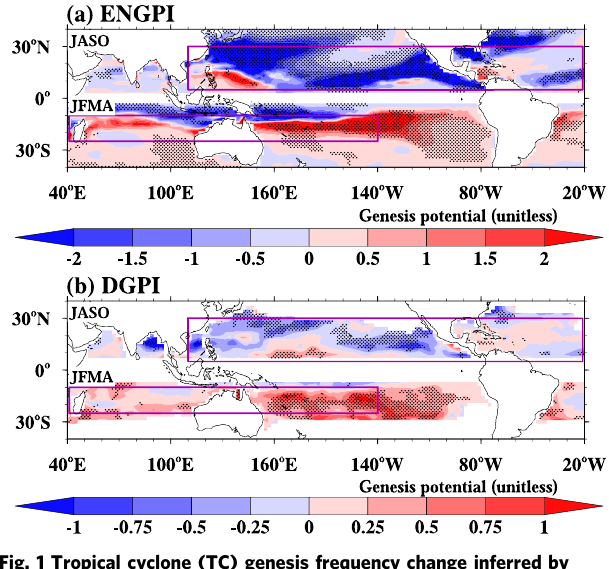
Fig. 1 Tropical cyclone (TC) genesis frequency change inferred by two empirical TC genesis potential indices (GPIs). a Emanuel-Nolan ’